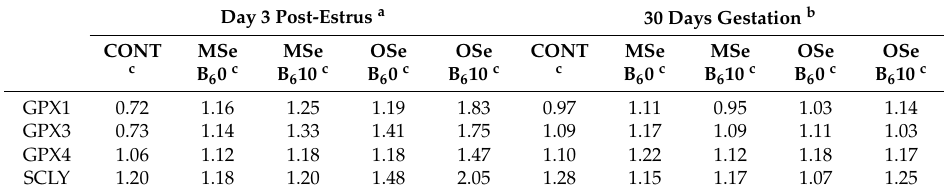
Table 2. Real-time mRNA abundance of kidney glutathione peroxidase (GPX) and selenocysteine-lyase (SCLY) genes in gilts three days after the fourth estrus and at day 30 of gestation, according to selenium and vitamin B 6